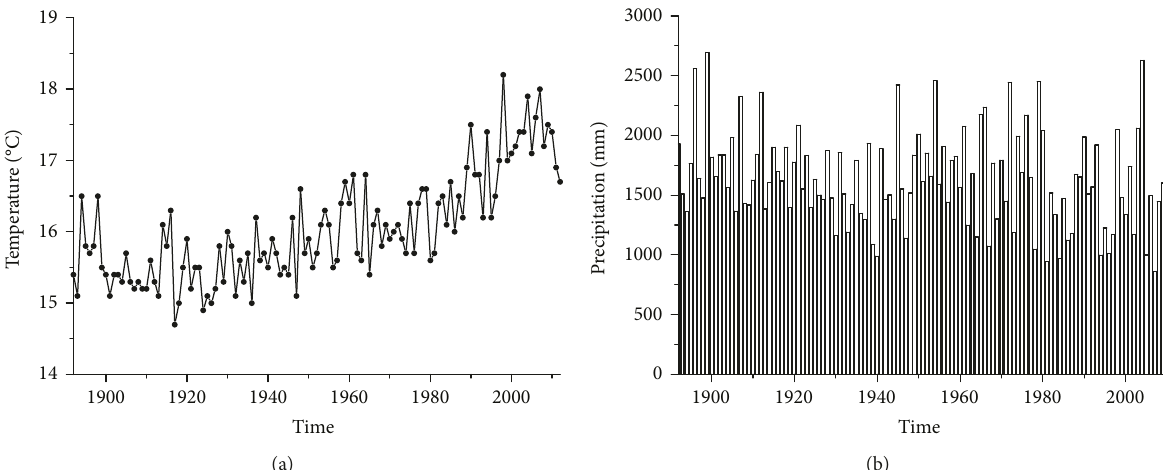
Figure 3: Diagram showing the (a) average annual air temperature and (b) annual precipitation amount at the Kumamoto meteorological station between 1890 and